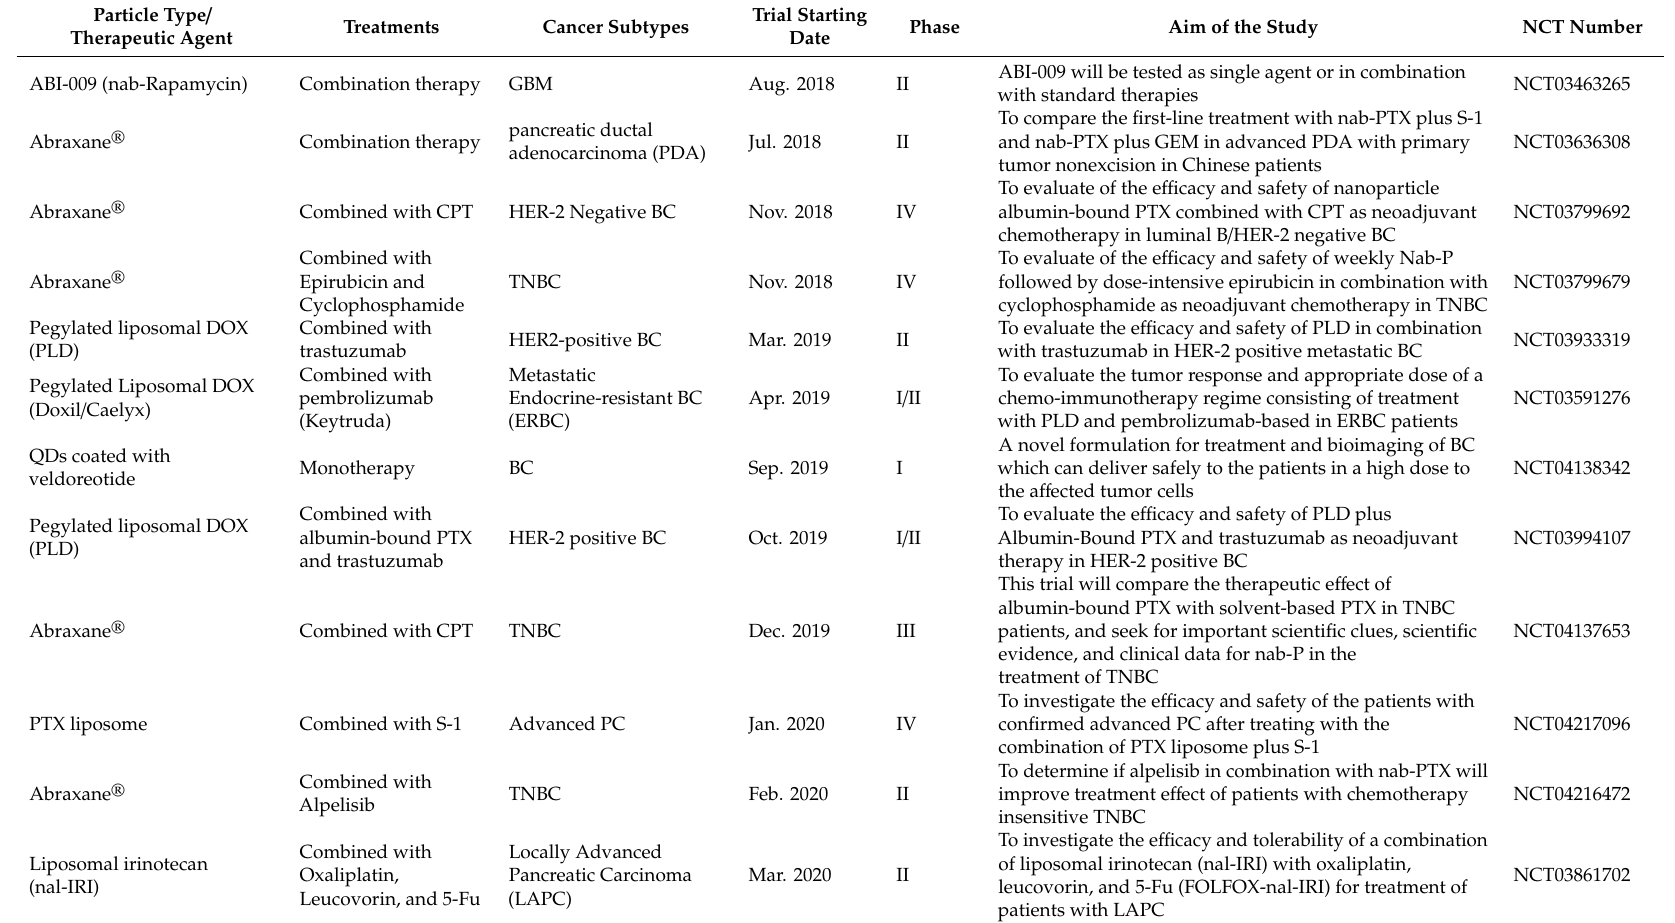
Table 3. A list of recent clinical trials of nanomedicines for the treatment of selected solid